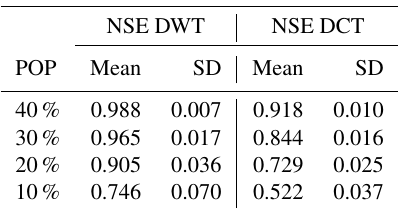
Figure 2. Empirical plots showing the relationship between RSR and the POP used for reconstructing an input rainfall signal using the DWT and DCT. The three catchments, from the top to the bot- tom of the figure, represent the smallest, largest and mean rainfall volumes throughout the 1990s for the MOPEX data set. Table 1. The mean and standard deviation (SD) of NSE for the DWT and DCT using a different